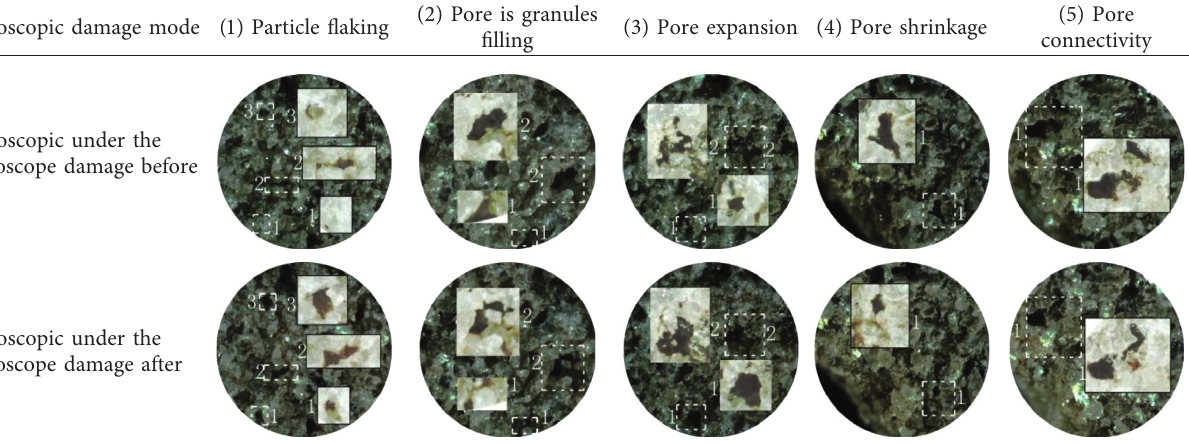
Table 1: Microdamage mode